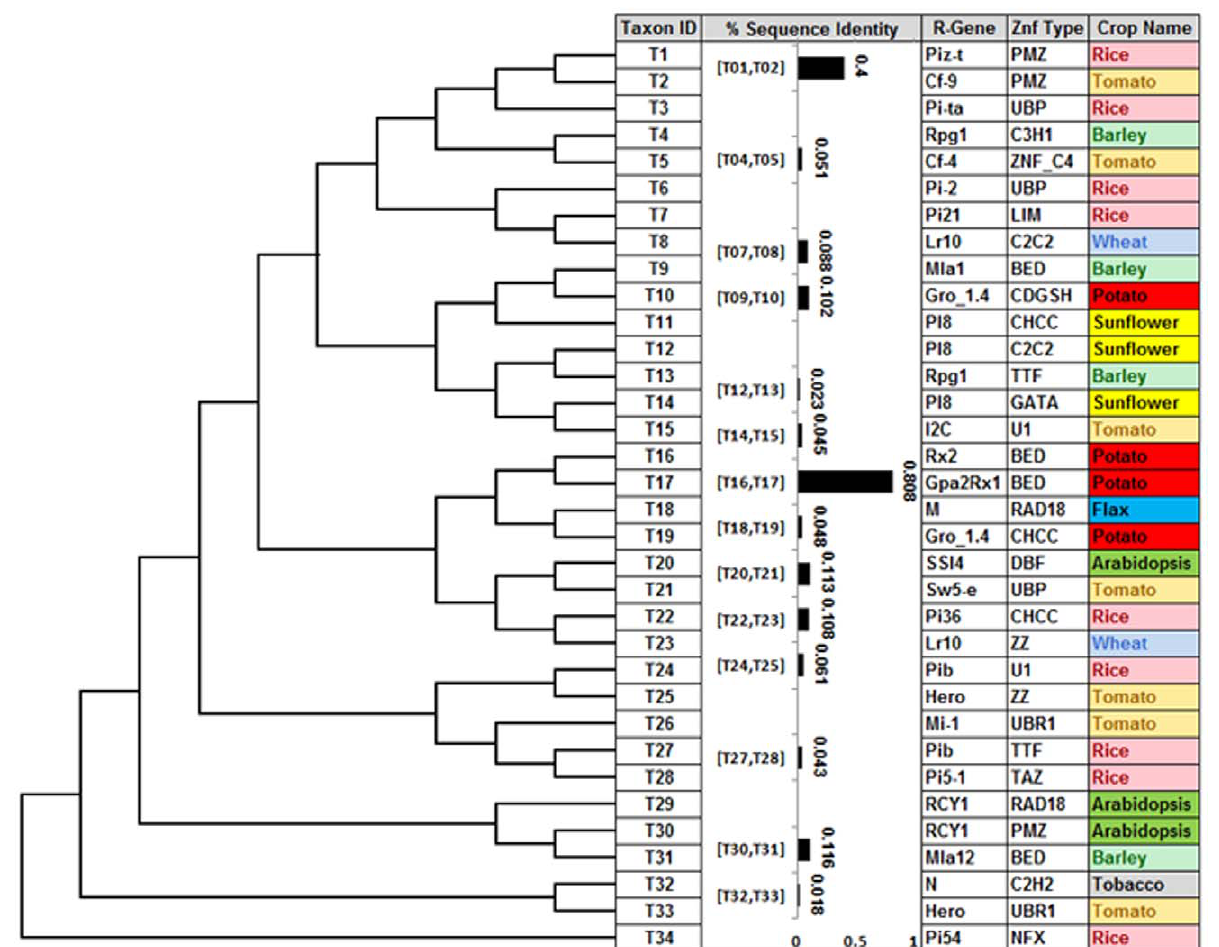
Figure 7. Maximum parsimony tree of 34 R genes containing zinc finger proteins. The bootstrap consensus tree (1000 replicates) is taken to represent the relationship between the taxa. Branches corresponding to partitions reproduced in less than 50% bootstrap replicates are collapsed. The percentage of replicate trees in which the associated taxa clustered together in the bootstrap test (1000 replicates) is shown next to the branches. The name of R gene, zinc finger types and crops are given on the termini of branches.